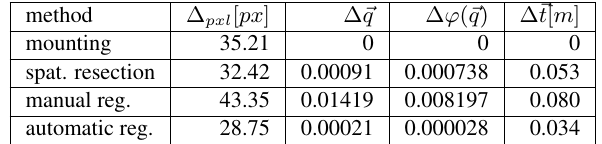
Table 1: Comparative accuracy of camera mounting, manual- and automatic registration with respect to ∆ pxl , rotational errors ∆ (cid:126)q and ∆ ϕ ( (cid:126)q ) , and ∆ (cid:126)t .